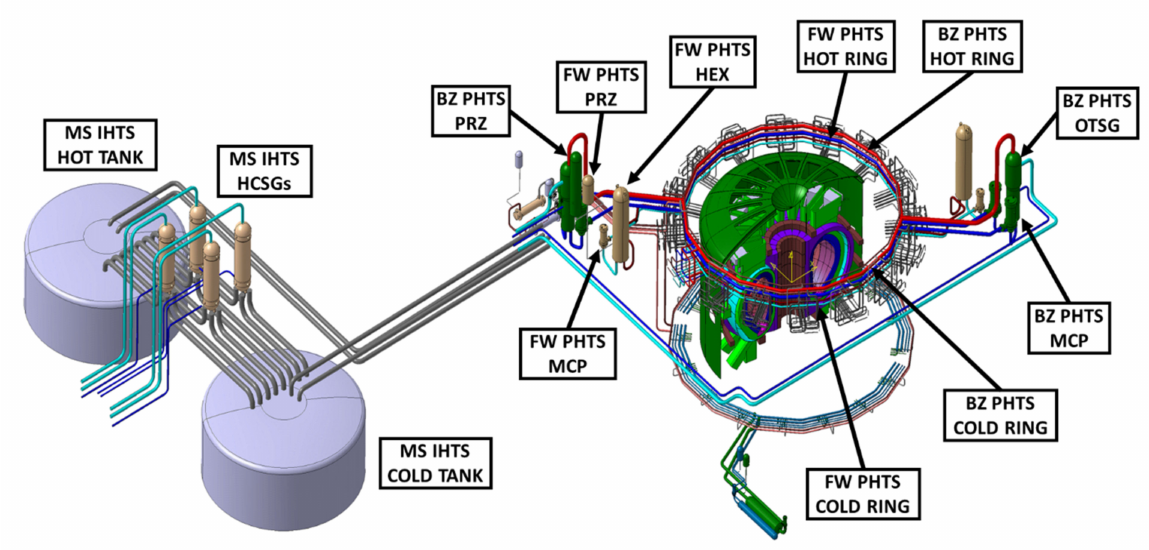
Figure 1. Reactor CAD model, DEMO 2017 baseline [2,4,5]. Overview of the tokamak, the primary cooling systems and the molten salt intermediate circuit and storage